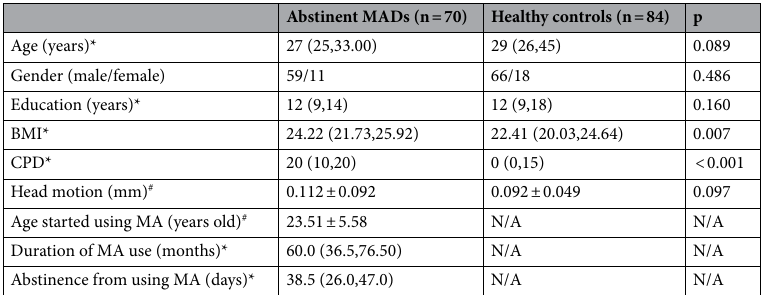
Table 1. Demographic characteristics of subjects. *Median (interquartile range) and Mann–Whitney test are presented. # Mean (standard deviation) and two sample t-test are